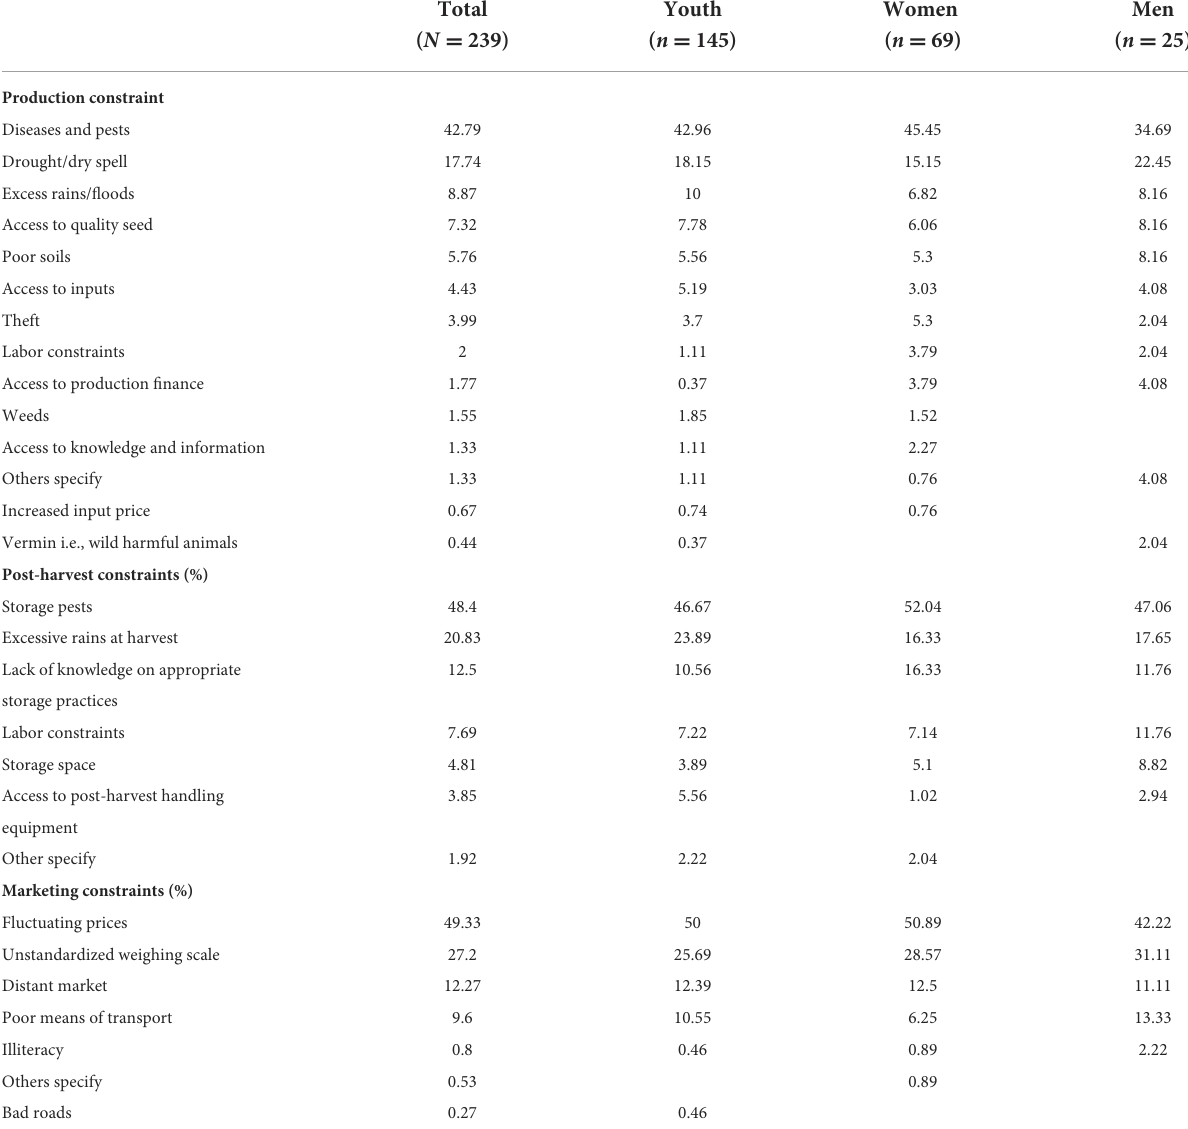
TABLE 3 Production, post-harvest, and market constraints experienced by farmers by gender.